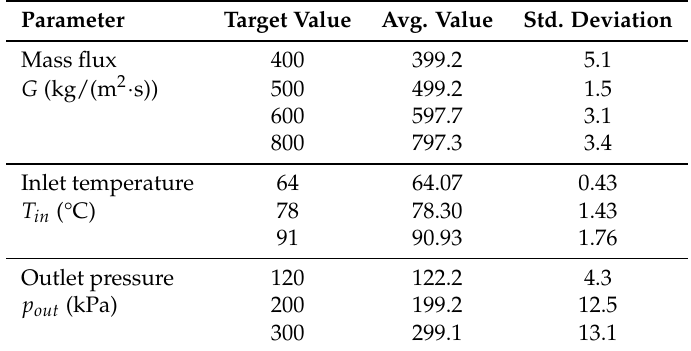
Table 3. Experimental setup of parameters with deviations.